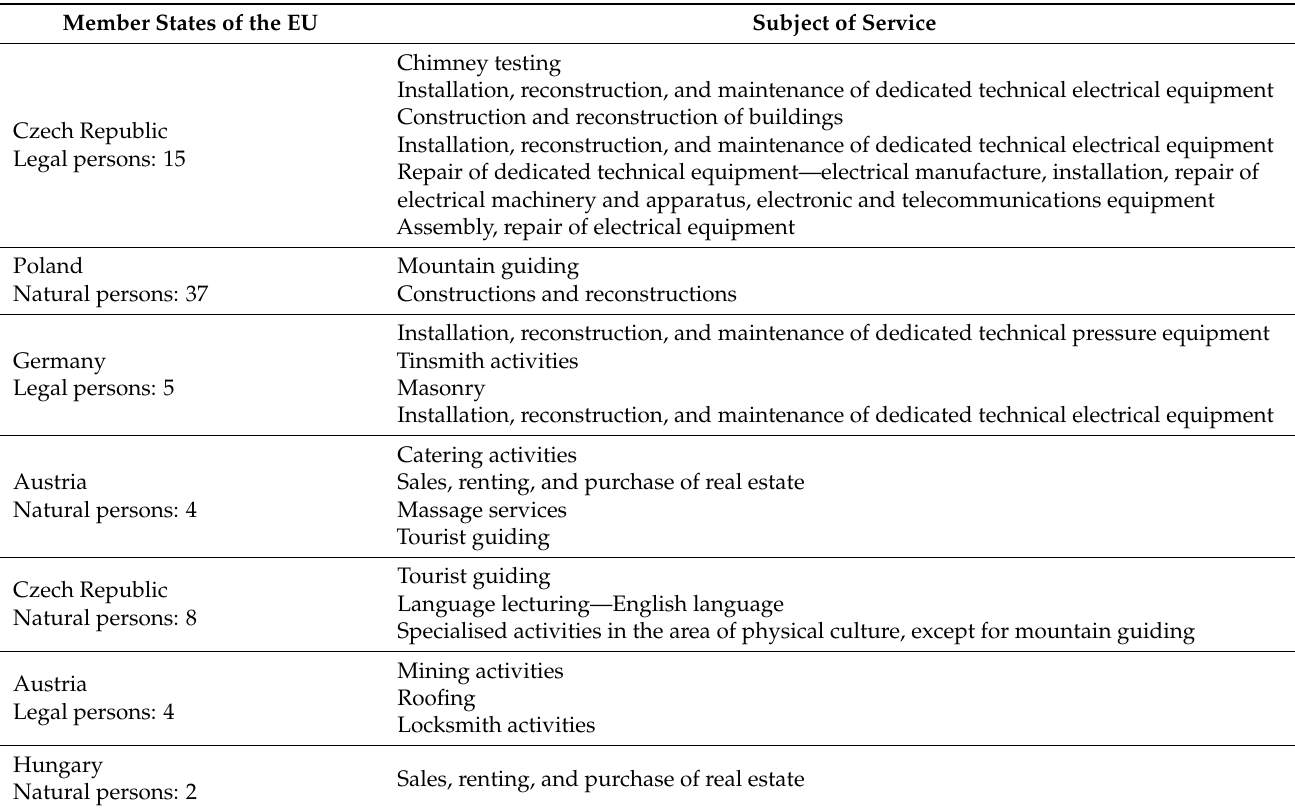
Table 1. Overview of cross-border services provided in Slovak